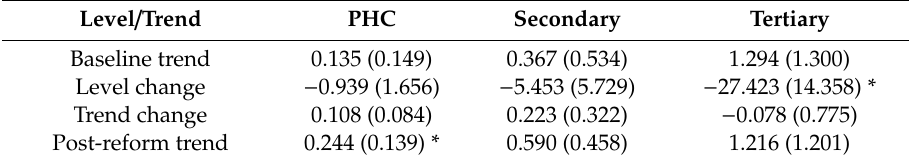
Table 5. The impacts of the Beijing Reform on monthly outpatient visits per healthcare facility type.